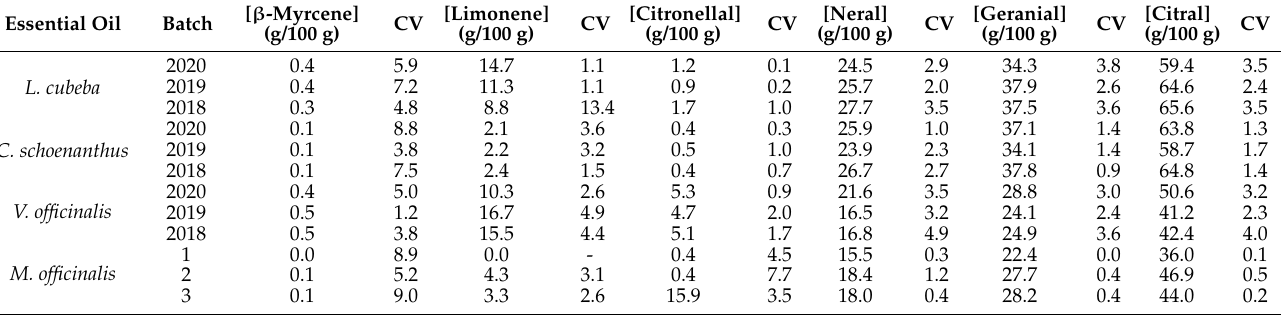
Table 3. Absolute concentrations of potentially bioactive components in the investigated essential oils. Essential